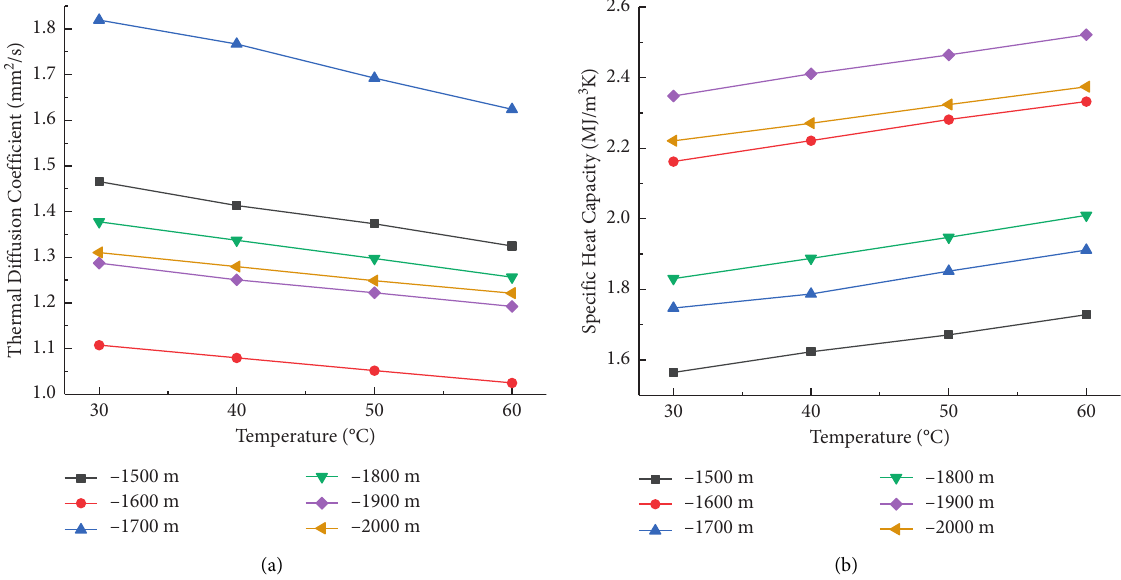
Figure 4: The thermal diffusion coefficient and specific heat capacity of the rock samples from the depth of 1,500–2,000m in the Xiling well construction project area of Sanshandao gold mine vary with temperature. Table 5: Fitting relationship between thermal diffusivity, specific heat capacity, and temperature of samples at various depths. Depth